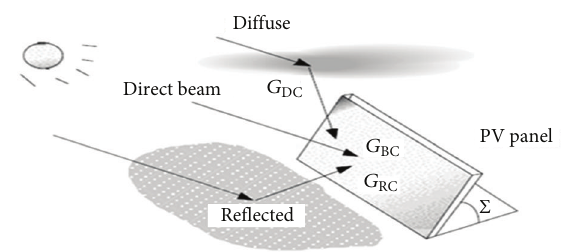
Figure 3: Direct, diffuse, and reflected beams that strike the PV panel.